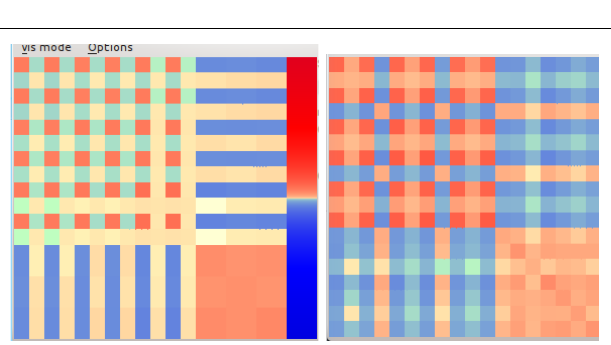
FIGURE 8 | Structure of the control matrix when in the jumping motion pattern (left) . The upper left 12 × 12 matrix, referring to the shoulder joints, shows a regular chess board-like pattern. In a later, more complex motion (right) the chess board pattern has been resolved into a more complex geometrical structure, indicating a more intricate cooperation between the various degrees of freedom. Quite generally, different modes correspond to different geometric patterns of the control